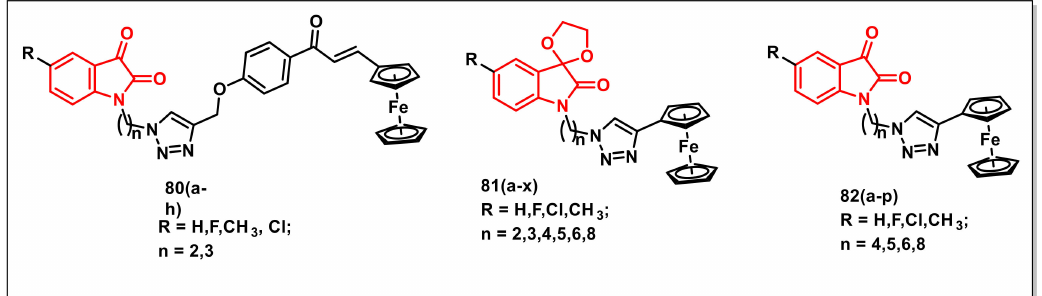
Figure 12. Ferrocene-tethered isatins as